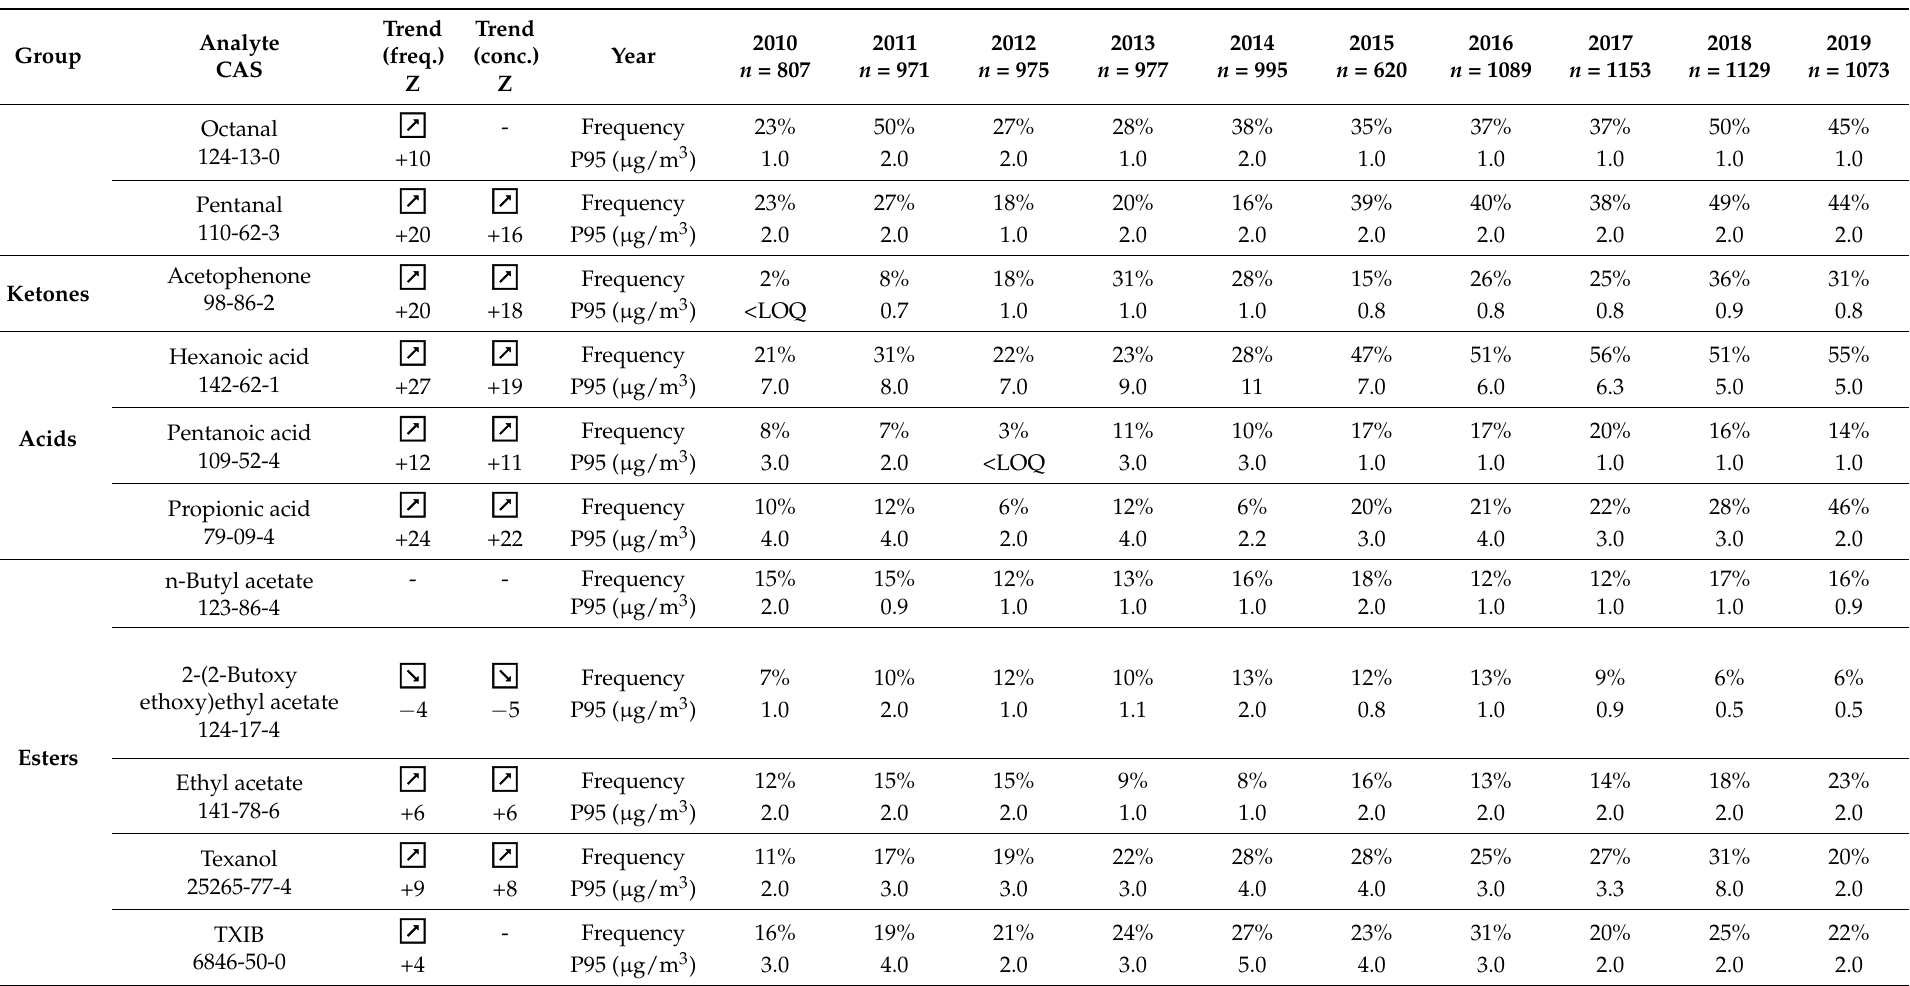
Table 4. Annual statistics of VOCs (a) and formaldehyde (b) during the ten-year study period 2010–2019. Frequency trend was tested using Somer’s D test, where input data were binomial (measurement result either >LOQ or <LOQ). Concentration trend was tested using Somer’s D test, where input data comprised all measured concentration values. Here, measurement results that were <LOQ were replaced by a concentration value LOQ/2. Trends indicated by downward or upward arrow symbol were statistically significant ( p < 0.0001) and had ǀ Z ǀ ≥ 4. Z values shown below arrow symbols indicate direction and steepness of trend.